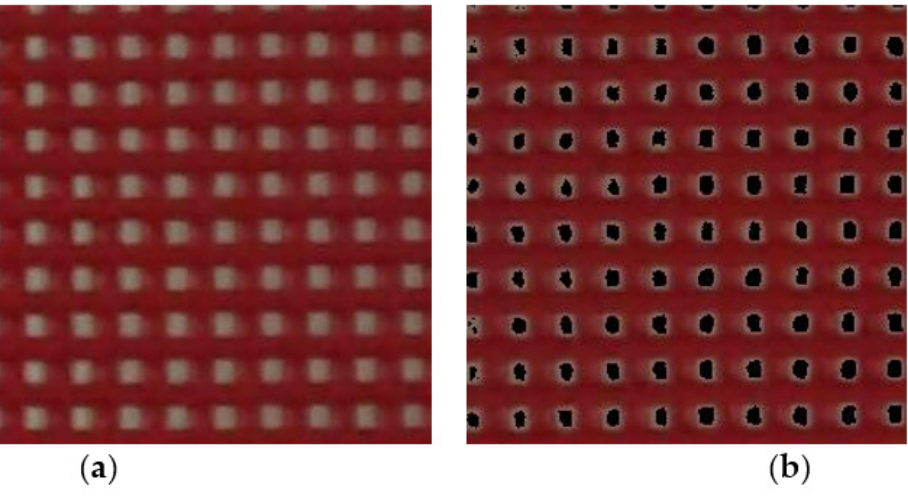
Figure 5. Image processing for background area removal: ( a ) before and ( b ) after background re- moval.